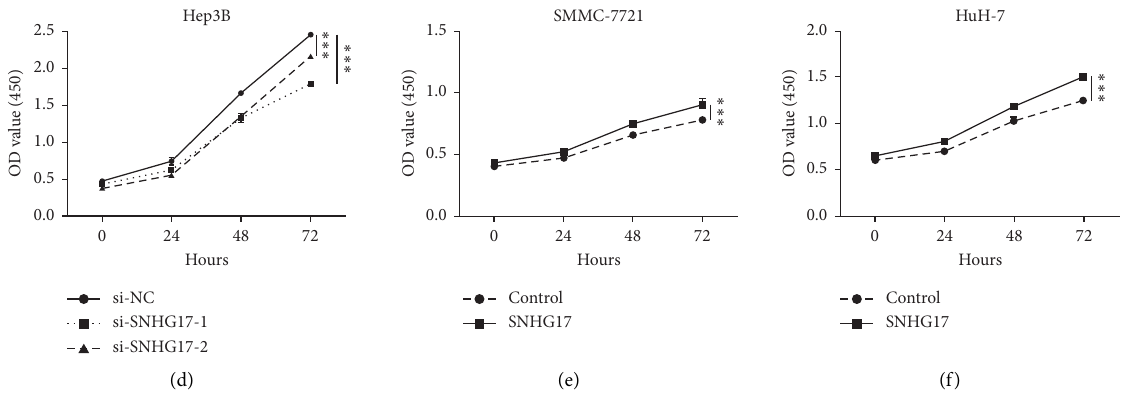
Figure 2: SNHG17 promoted cell proliferation of HCC. (a-b) SNHG17 expression level was determined by qRT-PCR in HCC cells as indicated. (c-d) CCK8 assays were employed to detected the effect of SNHG17 on the cell viability of PLC/PRF/5 and Hep3B cells. (e-f) CCK8 assays were employed to detect the effect of SNHG17 on the cell viability of SMMC-7721 and HuH-7 cells. ∗ P < 0 . 05 and ∗∗∗ P < 0 .